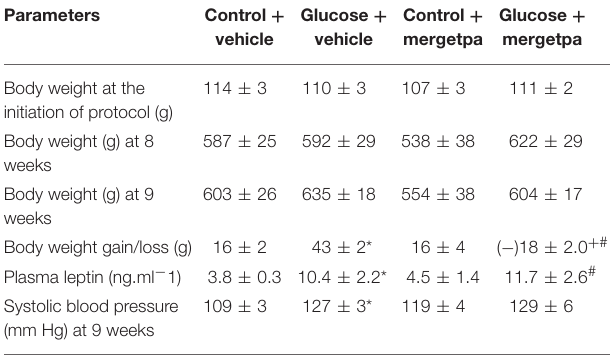
TABLE 1 | Body weight, plasma leptin levels and systolic blood pressure.